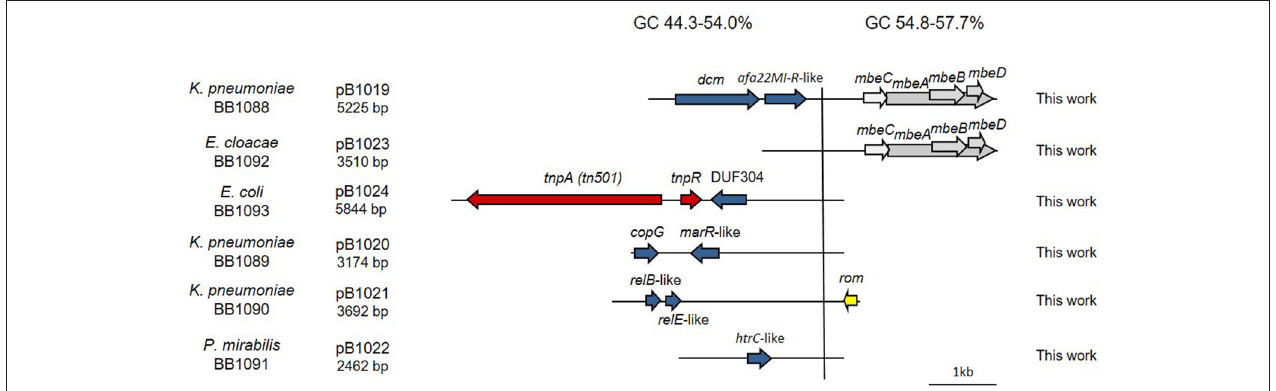
FIGURE 5 | Genetic structure of ColE1 plasmids from Enterobacteriaceae clinical isolates. Schematic diagram of the ColE1 plasmids from the Enterobacteriaceae family described here. The reading frames for genes are shown as arrows, with the direction of transcription indicated by the arrowhead. The names of the genes, or the names of the family of proteins they encode, are indicated. Genes involved in genetic transposition or integration are shown in red. Genes encoding plasmid relaxases are shown in gray and the rom gene involved in the regulation of plasmid replication is shown in yellow. The remaining ORFs are shown in blue. Percentage ranges of GC content of variable and conserved regions of the plasmids are indicated in the top of the figure. The vertical bar separates the conserved region of the plasmids, to the right, from the variable region of the plasmids, to the left. The strain in which the plasmid was described, and the name and size of the plasmids, are also